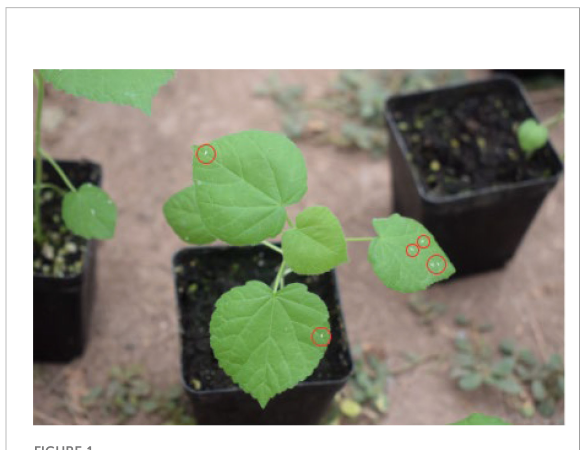
FIGURE 1 Small inset targets in the actual